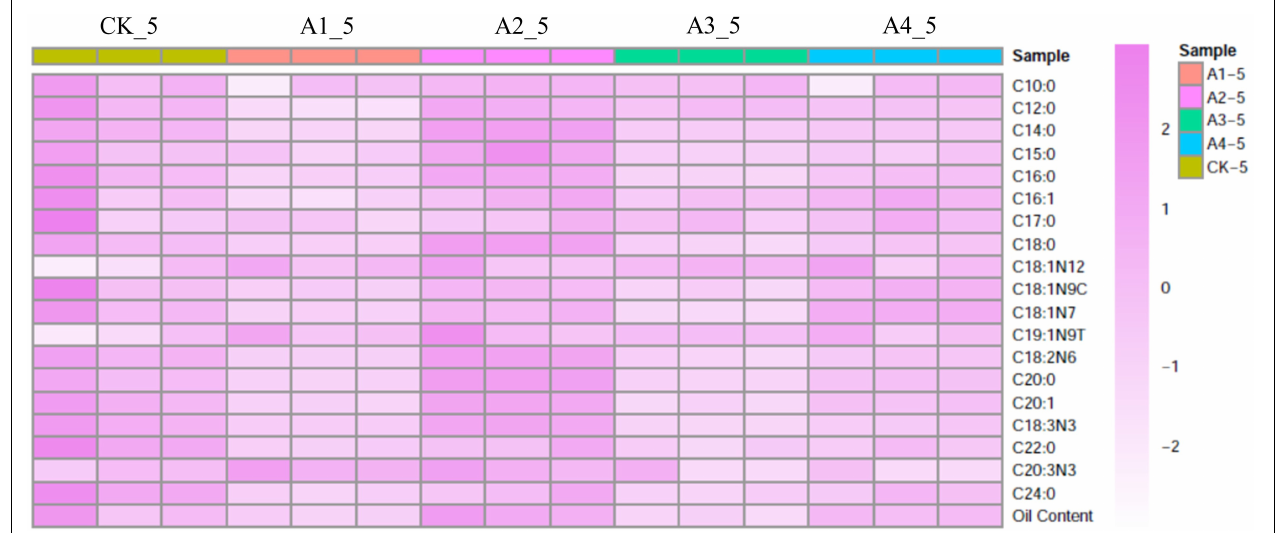
FIGURE 1 | Heat map of fatty acid composition content after different exogenous ABA treatments. CK, treatment with 0 µ M ABA; A1, treatment with 10 µ M ABA; A2, treatment with 20 µ M ABA; A3, treatment with 50 µ M ABA; A4, treatment with 200 µ M ABA. Each colored cell on the map corresponds to a concentration value. TABLE 2 | Categorization and a summary of abundance of RNA-seq reads and genes in 18 libraries.